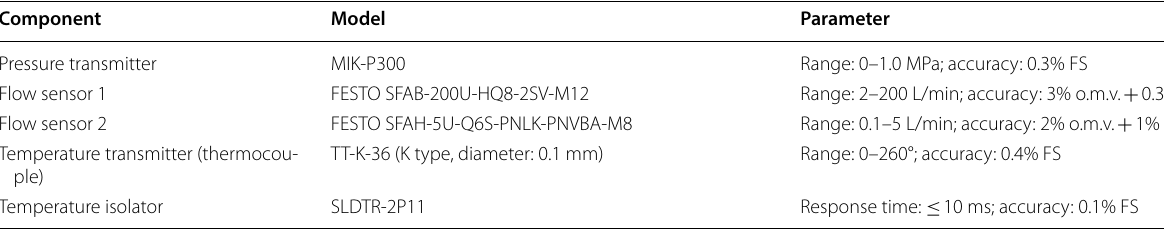
Table 2 Models and parameters of the test components